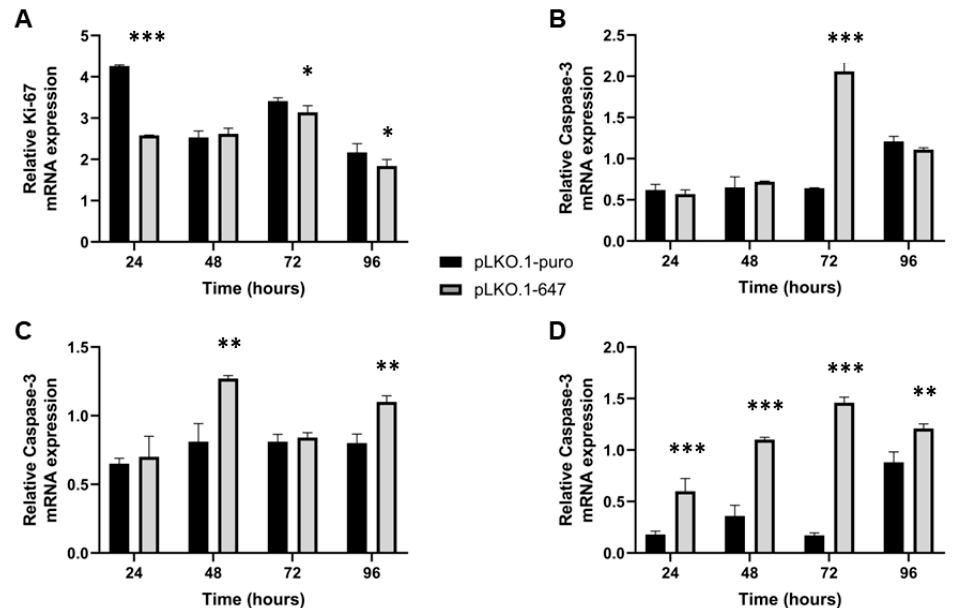
Figure 5. Real-Time PCR analysis of cell proliferation and apoptosis induction in HSC-3 cells, Figure 5. Real ‒ Time PCR analysis of cell proliferation and apoptosis induction in HSC ‒ 3 cells, treated with CDDP. Expression of Ki-67 ( A ), Caspase-3 ( B ), -8 ( C ) and -9 ( D ) was evaluated in treated with CDDP. Expression of Ki ‒ 67 ( A ), Caspase ‐ 3 ( B ), ‐ 8 ( C ) and ‐ 9 ( D ) was evaluated in control (pLKO.1-puro) and PON2 downregulating (pLKO.1-647) cells. Values are expressed as control (pLKO.1 ‒ puro) and PON2 downregulating (pLKO.1 ‒ 647) cells. Values are expressed as mean ± standard deviation (* p < 0.05; ** p < 0.01; *** p < mean ± standard deviation (* p < 0.05; ** p < 0.01; *** p < 0.005).